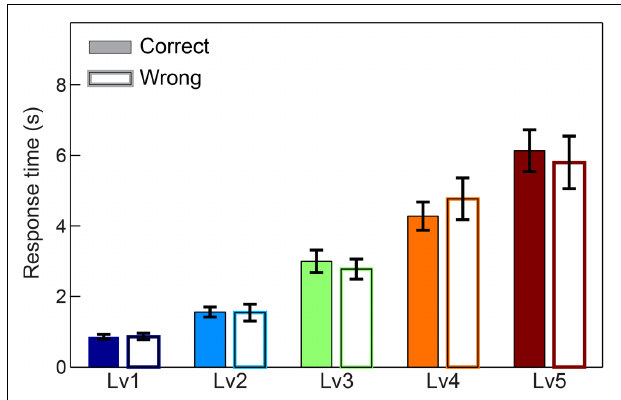
FIGURE 2 | Response times across five CWL in both correct and wrong trials. Bars represent mean ± standard error of mean (SEM). No significant difference was observed in the response time between correct and wrong